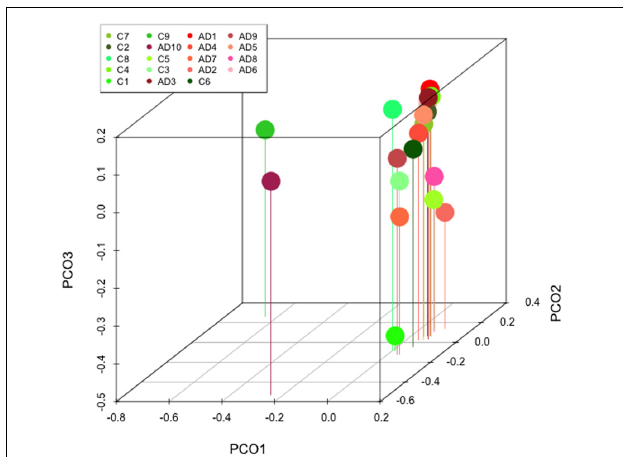
FIGURE 12 | Principal component analysis of AD and control samples: 3D principal component analysis scatter plots of bacteria from ten AD patients and nine controls. The UniFrac method was used to calculate this